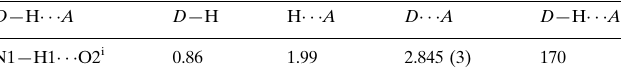
Hydrogen-bond geometry (A˚ , (cid:2)